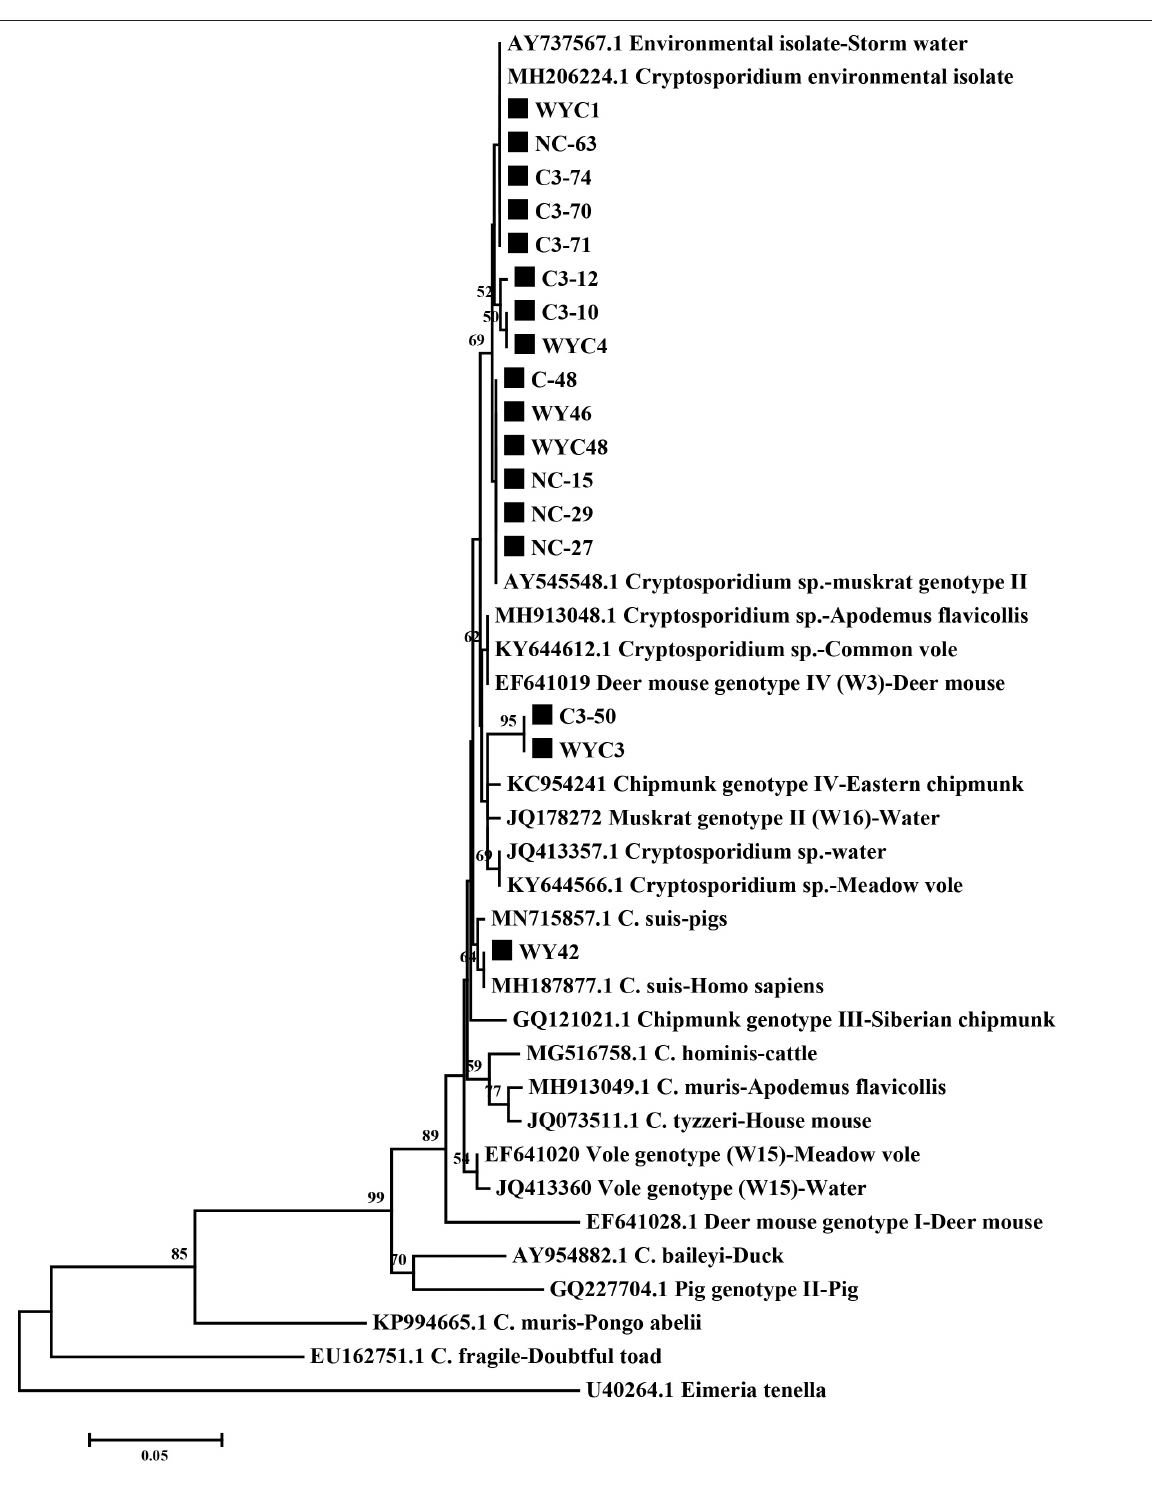
FIGURE 1 | Phylogenetic analysis of Cryptosporidium spp. using Neighbor-Joining (NJ) method based on sequences of the small subunit ribosomal RNA (SSU rRNA) gene. Bootstrap values > 50% are shown (1,000 replicates). Isolates obtained in the present study are indicated by solid square. The SSU rRNA gene sequence of Eimeria tenella is used as the